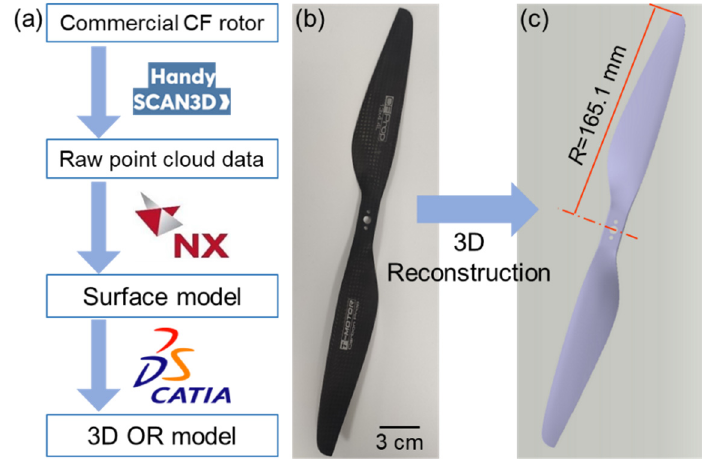
Figure 2. 3D reconstruction process. ( a ) Workflow of 3D reconstruction model of OR via inverse engineering method; ( b ) A commercial CF rotor; ( c ) The obtained 3D reconstruction model of the OR.